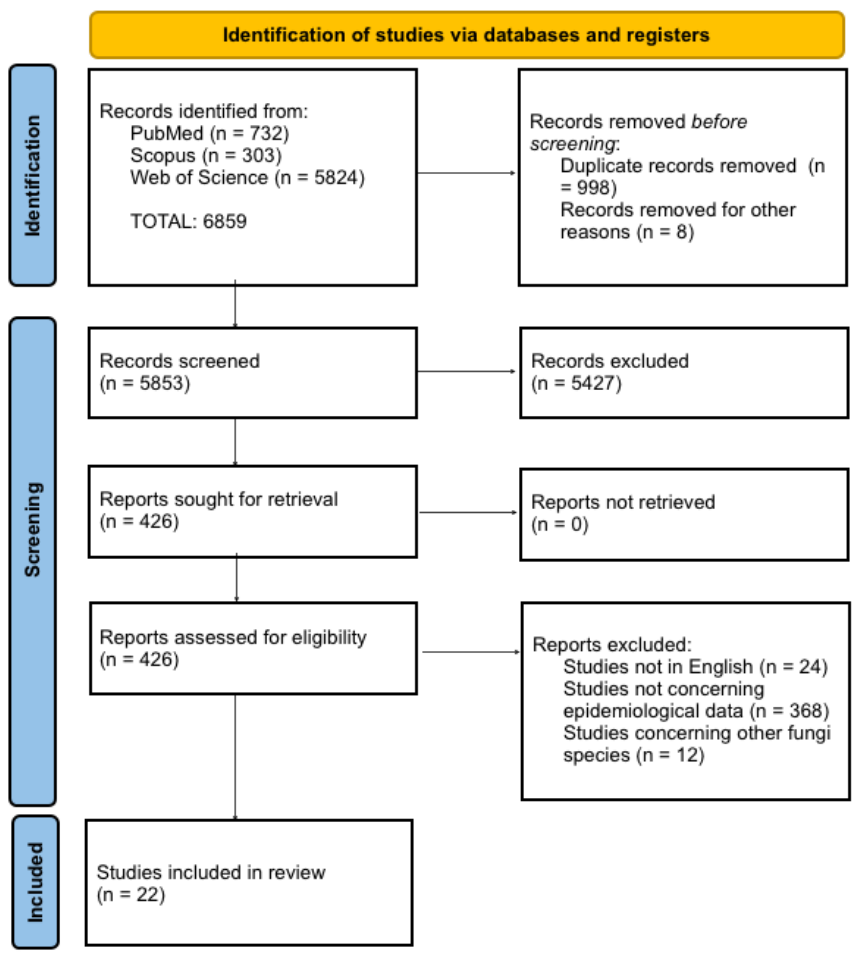
Figure 1. PRISMA flow diagram.